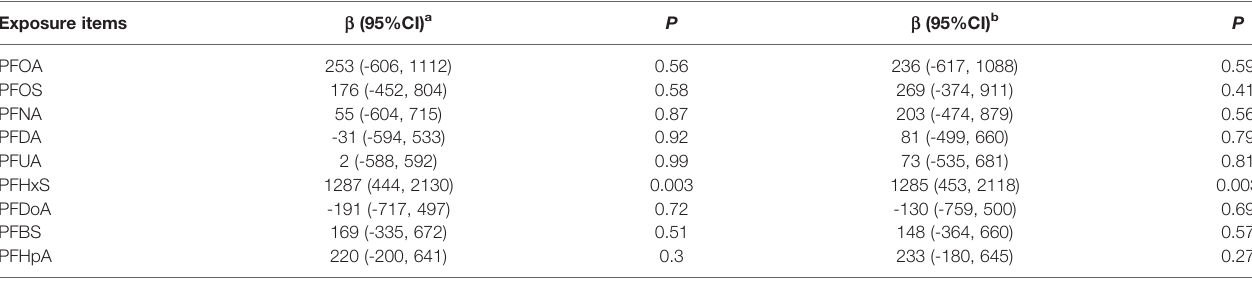
TABLE 3 | Associations of log-transformed PFAS concentration during pregnancy with BDNF levels in cord blood * . Exposure